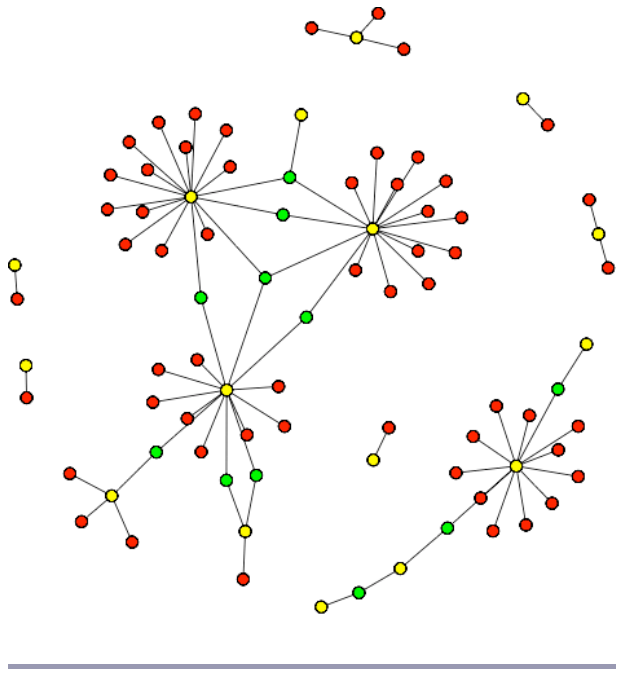
Fig. 1 . Network diagram of the traders (yellow circles) and fishers (red and green circles) that responded to the questionnaire. Freelancers (green circles) have multiple connections to the traders. Names are not shown and fishers who did not indicate a specific trader are